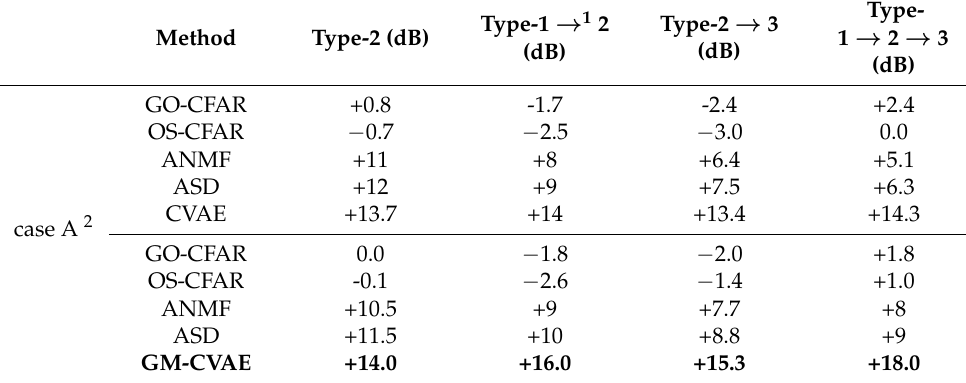
Table 1. SNR Improvement of the Referred Methods with Respect to